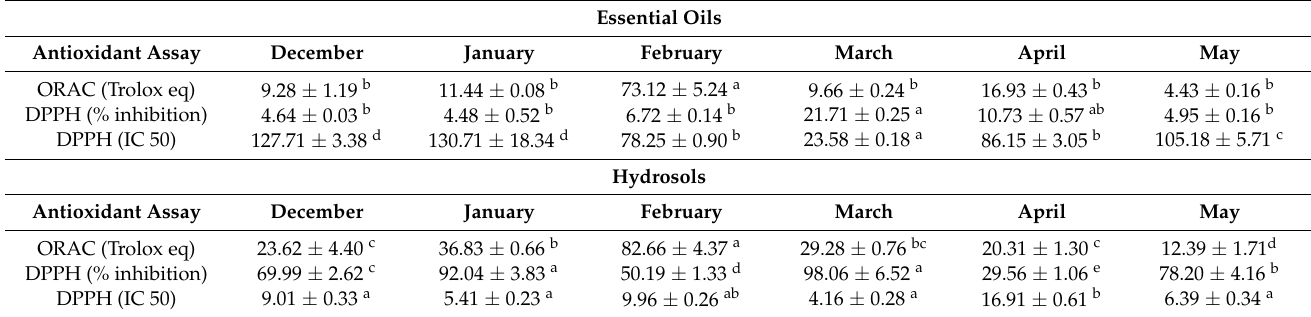
Table 4. Antioxidant capacity of the EOs and hydrosols of Olea europaea L. cv. Oblica over the period of six months. Essential Oils